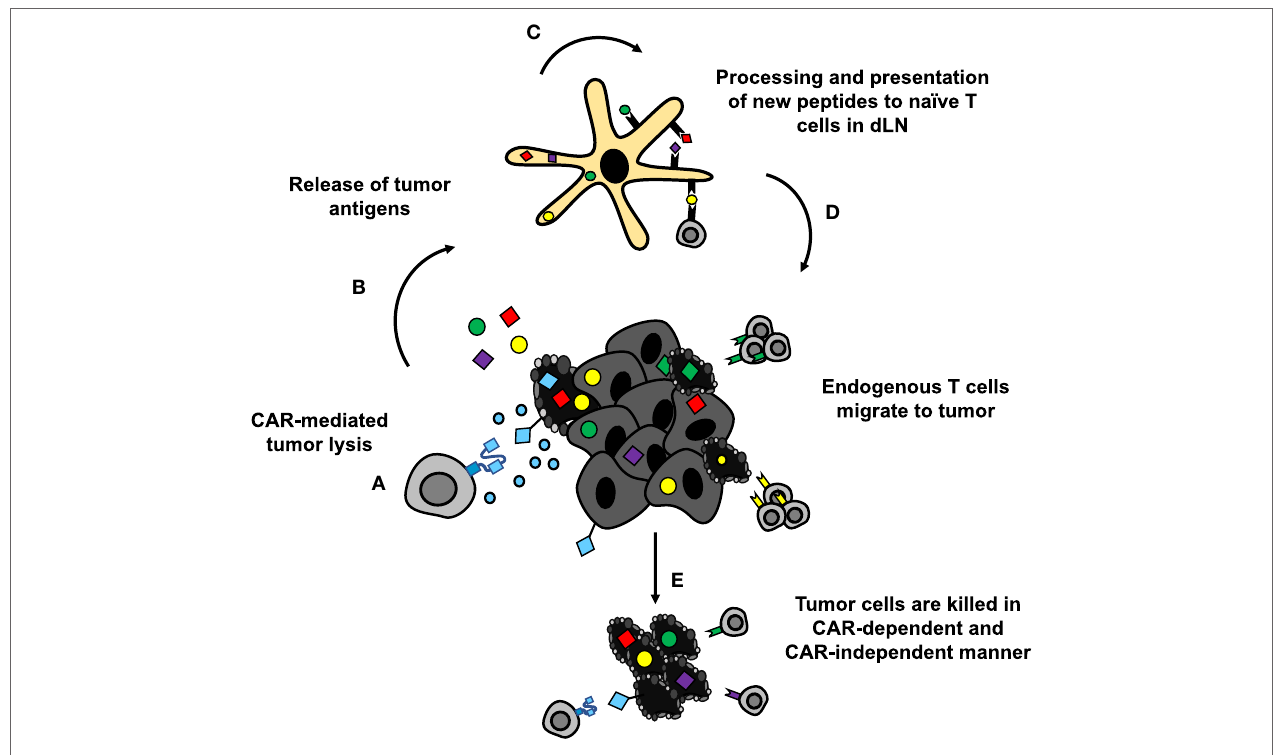
FigURe 6 | CAR-mediated tumor destruction can synergize with host immunity through epitope spreading. (A,B) Chimeric antigen receptor (CAR)-mediated tumor cell lysis induces inflammation, and release of tumor antigens. (C) DAMPs from dying cells recruit APCs to tumor site, which take up and process the released antigens for presentation. (D) APCs present newly processed tumor antigens to naïve T cells in lymph nodes. Activated T cells migrate to the tumor site. (e) Tumor-specific lymphocytes synergize with CAR T cells to eradicate difficult to treat solid